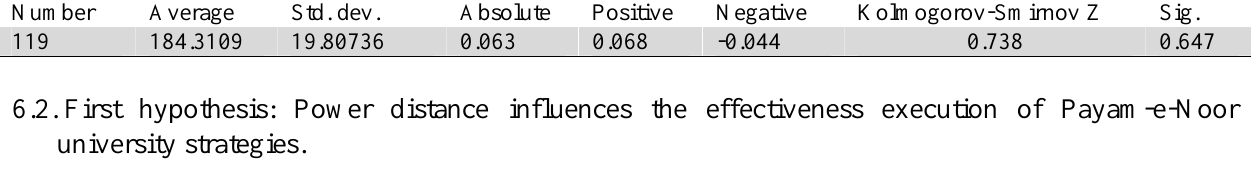
Pearson Correlation Coefficient between Power Distance and Effectiveness of Strategies Pearson Correlation Coefficient Abundance Average Effectiveness of strategies